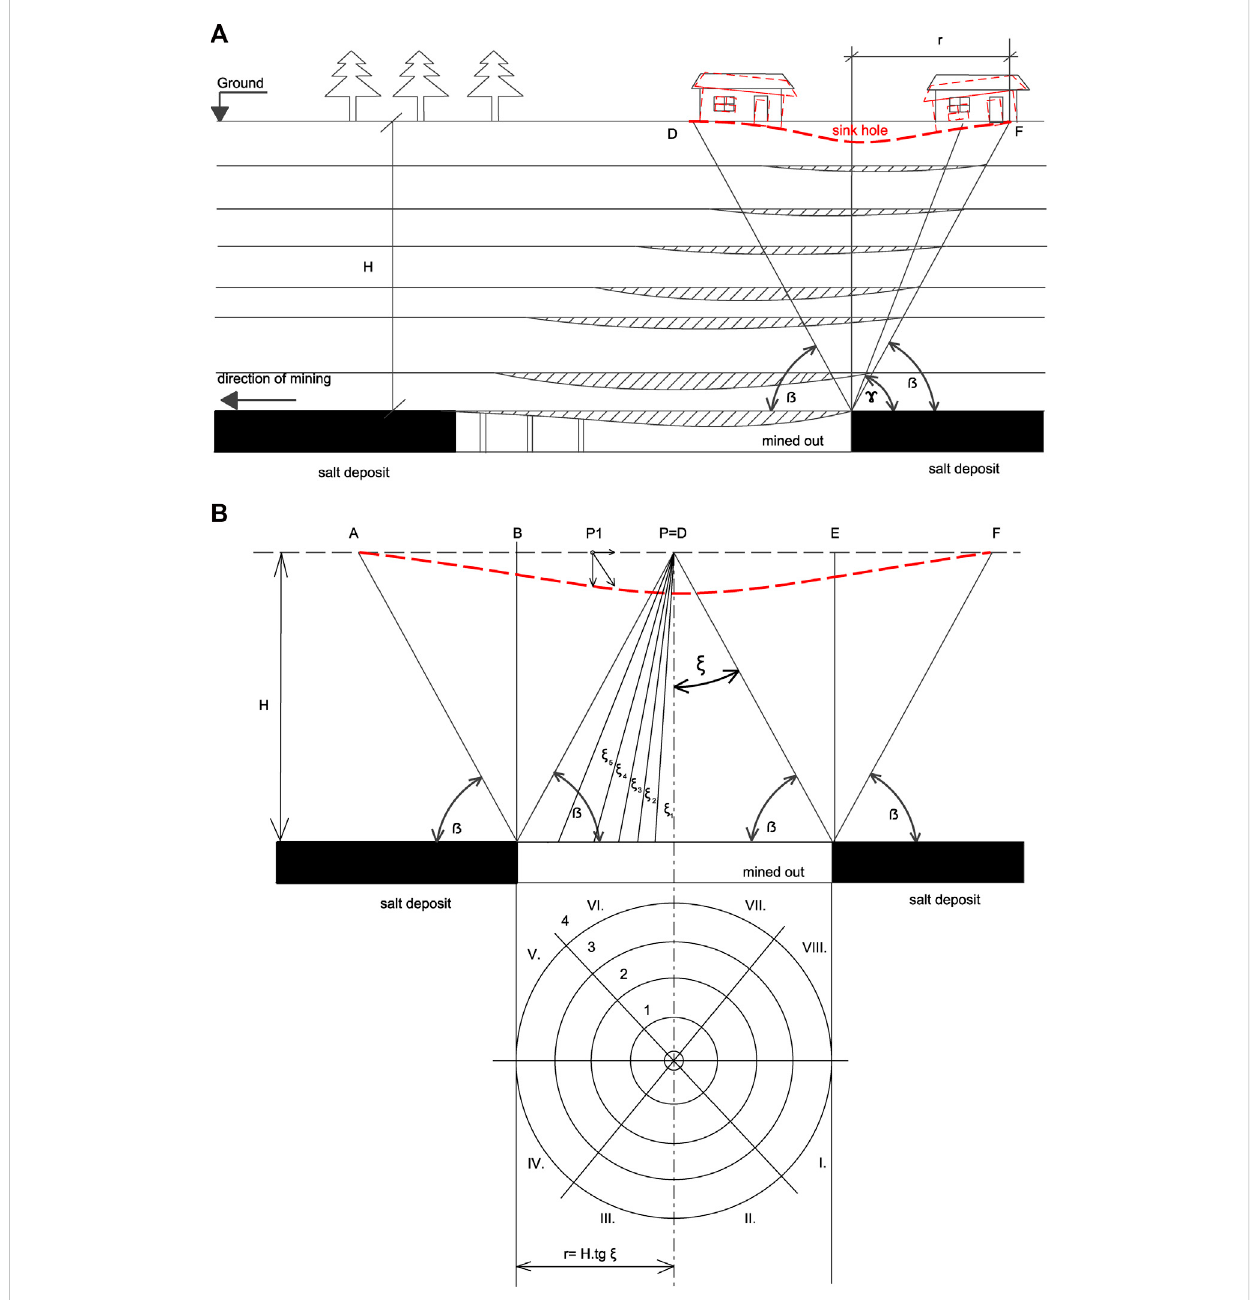
FIGURE 2 (A) Creation of a sinkhole and (B) Meaning of the effective area, P-point drop scheme on the effective area (Trnka et al.,